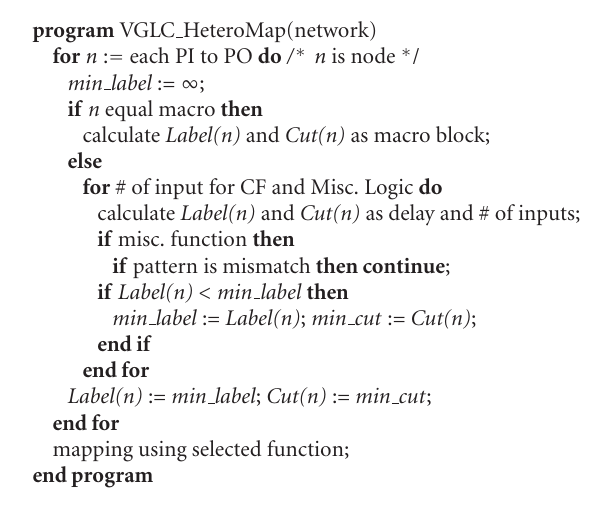
Algorithm 1: Pseudocode in random logic mapping.